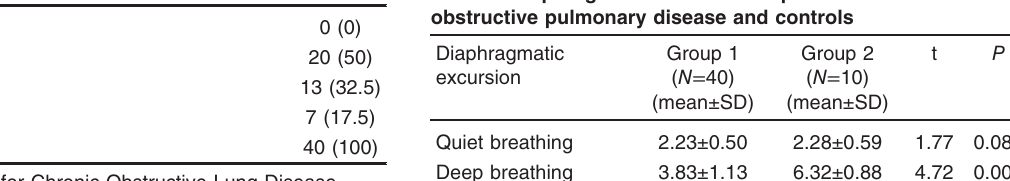
Table 4 Diaphragmatic excursion in patients with chronic obstructive pulmonary disease and controls